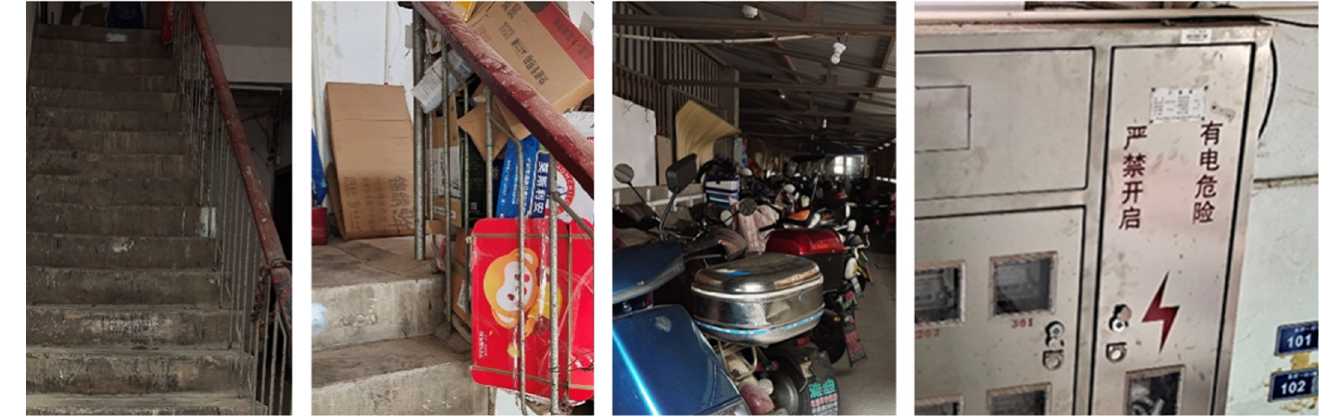
Figure 10. Public environment of the unit (photographed by Yuxin Xu in 2022).